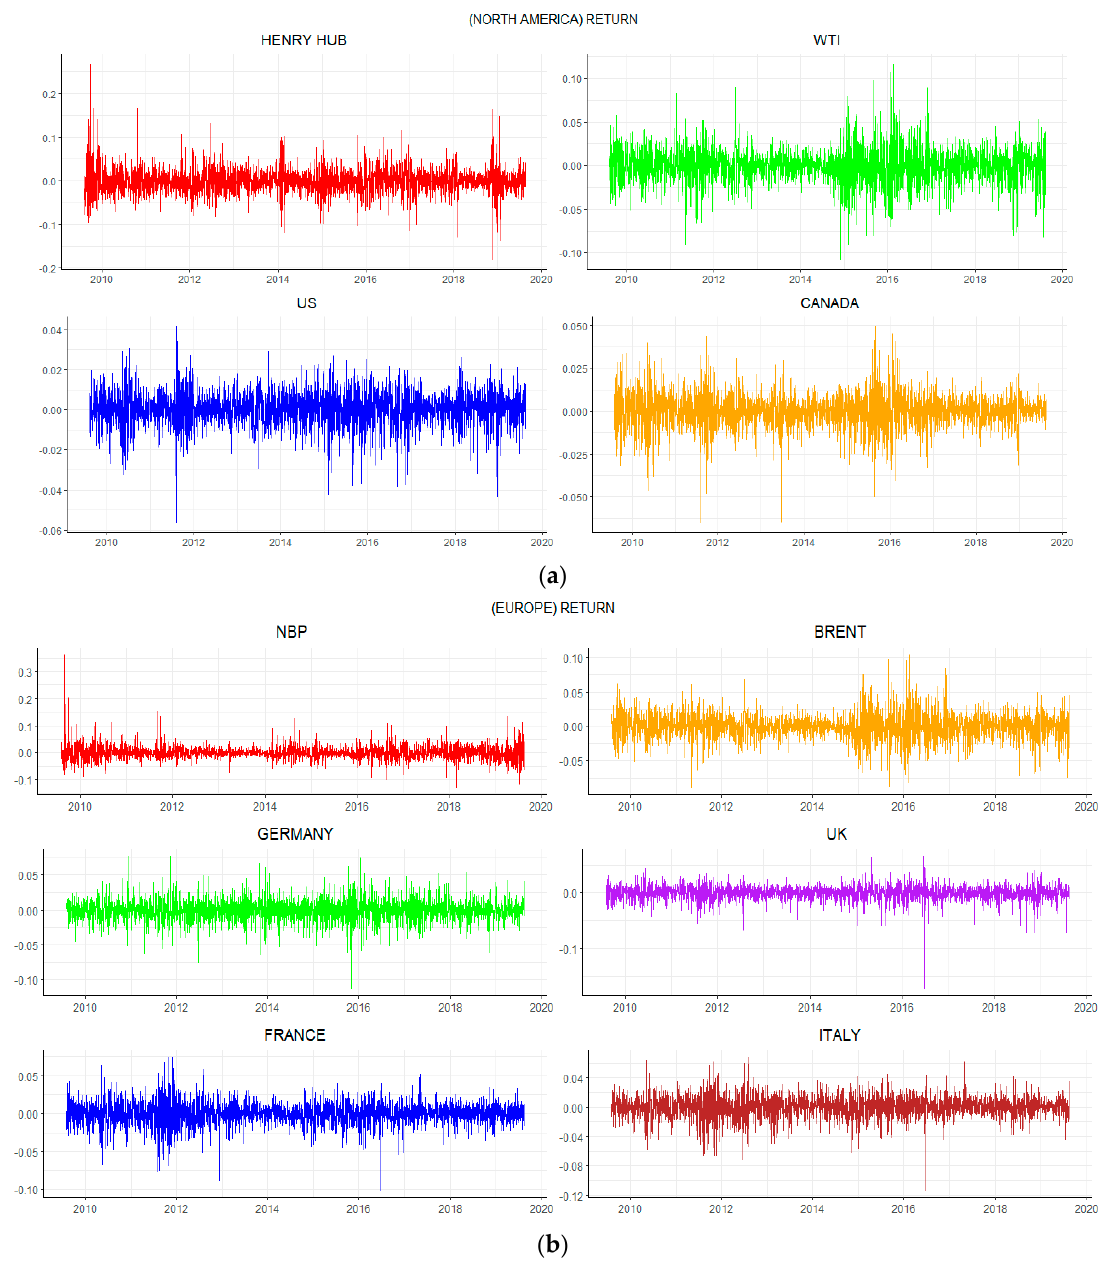
Figure 2. ( a ) Time-variations of the return series in North America. Notes: Henry Hub indicates natural gas; WTI indicates crude oil; US indicates the S&P 500 Utilities Index; CANADA indicates the S&P/TSX Capped Utilities Sector Index. ( b ) Time-variations of return series in Europe. Notes: NBP indicates natural gas; BRENT indicates crude oil; GERMANY indicates the DAX subsector for all electricity; UK indicates the FTSE 350 Electricity Index; FRANCE indicates the CAC Utilities Index; ITALY indicates FTSE Italia All-Share Utilities Index.